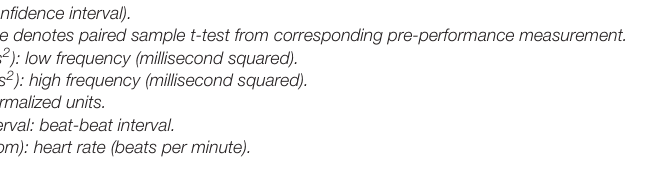
TABLE 4 | Zero order correlations for the first 2.5-min segments of pre-performance HRV, Anxiety and Flow during Bach performance. Variable Mean flow Baseline HADS anxiety